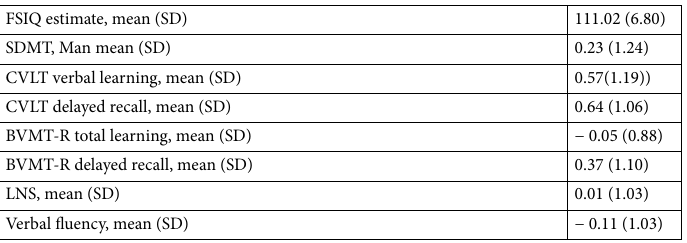
Table 2. Cognitive functioning results (z-scores) for full IBD sample. FSIQ Full Scale Intellectual Quotient, SDMT Symbol Digits Modality Test, CVLT California Verbal Learning Test, 2nd Ed., BVMT-R Brief Visualspatial, Test – Revised, LNS Letter Number Sequencing Test.